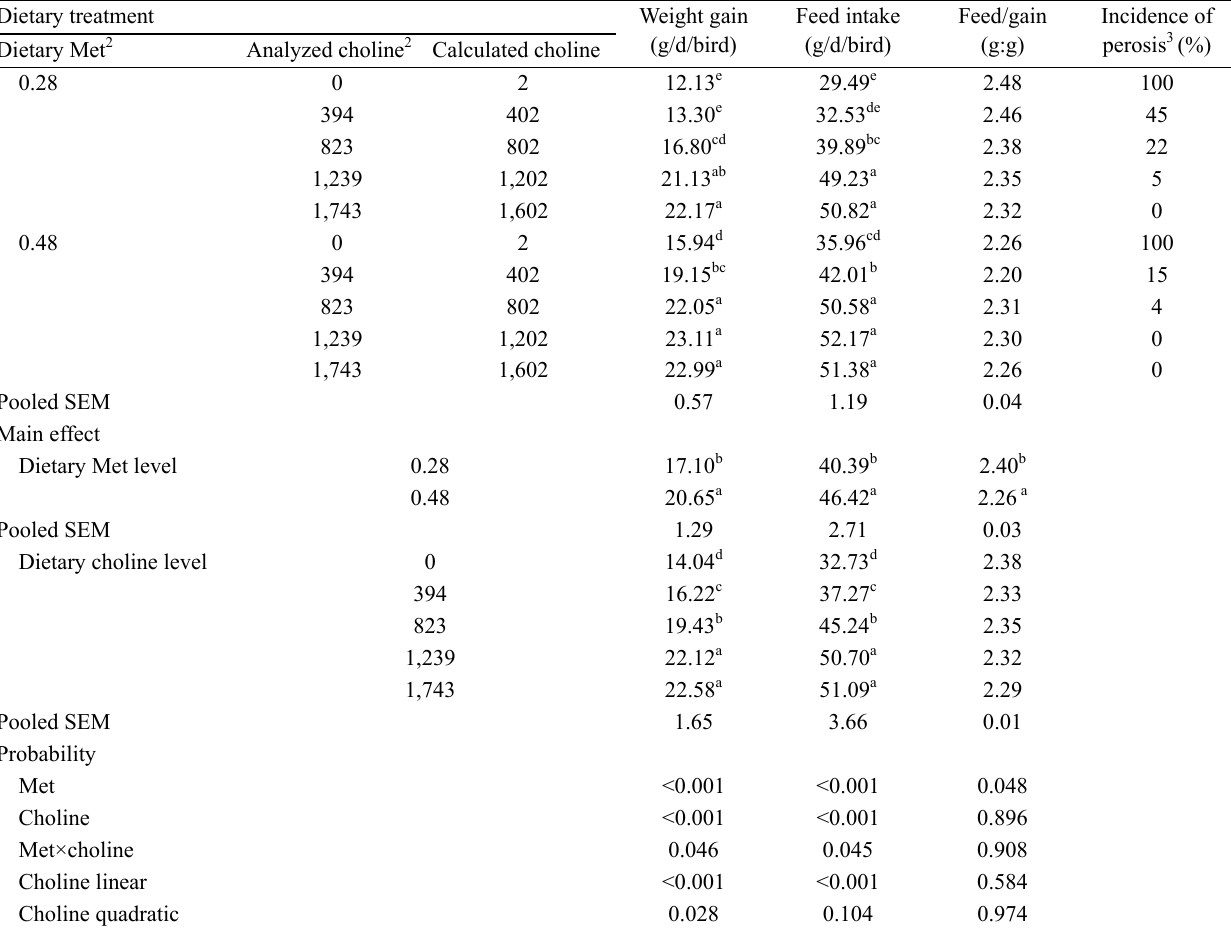
Table 2. Effect of dietary choline on growth performance and perosis of Pekin ducks from 7 to 28 d of age at two dietary methionine level 1 Dietary treatment